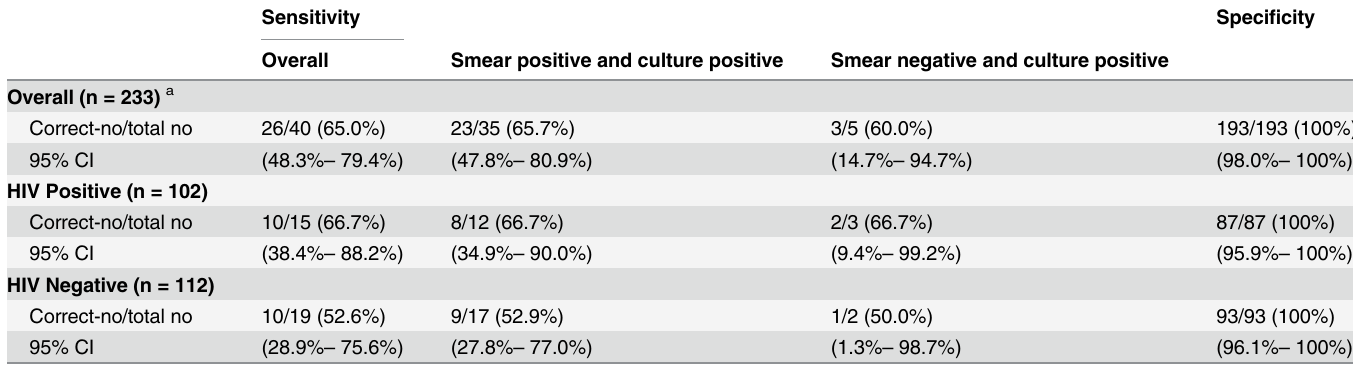
Table 2. Sensitivity and specificity of LAMP (compared to MGIT) by HIV status and smear status (n =